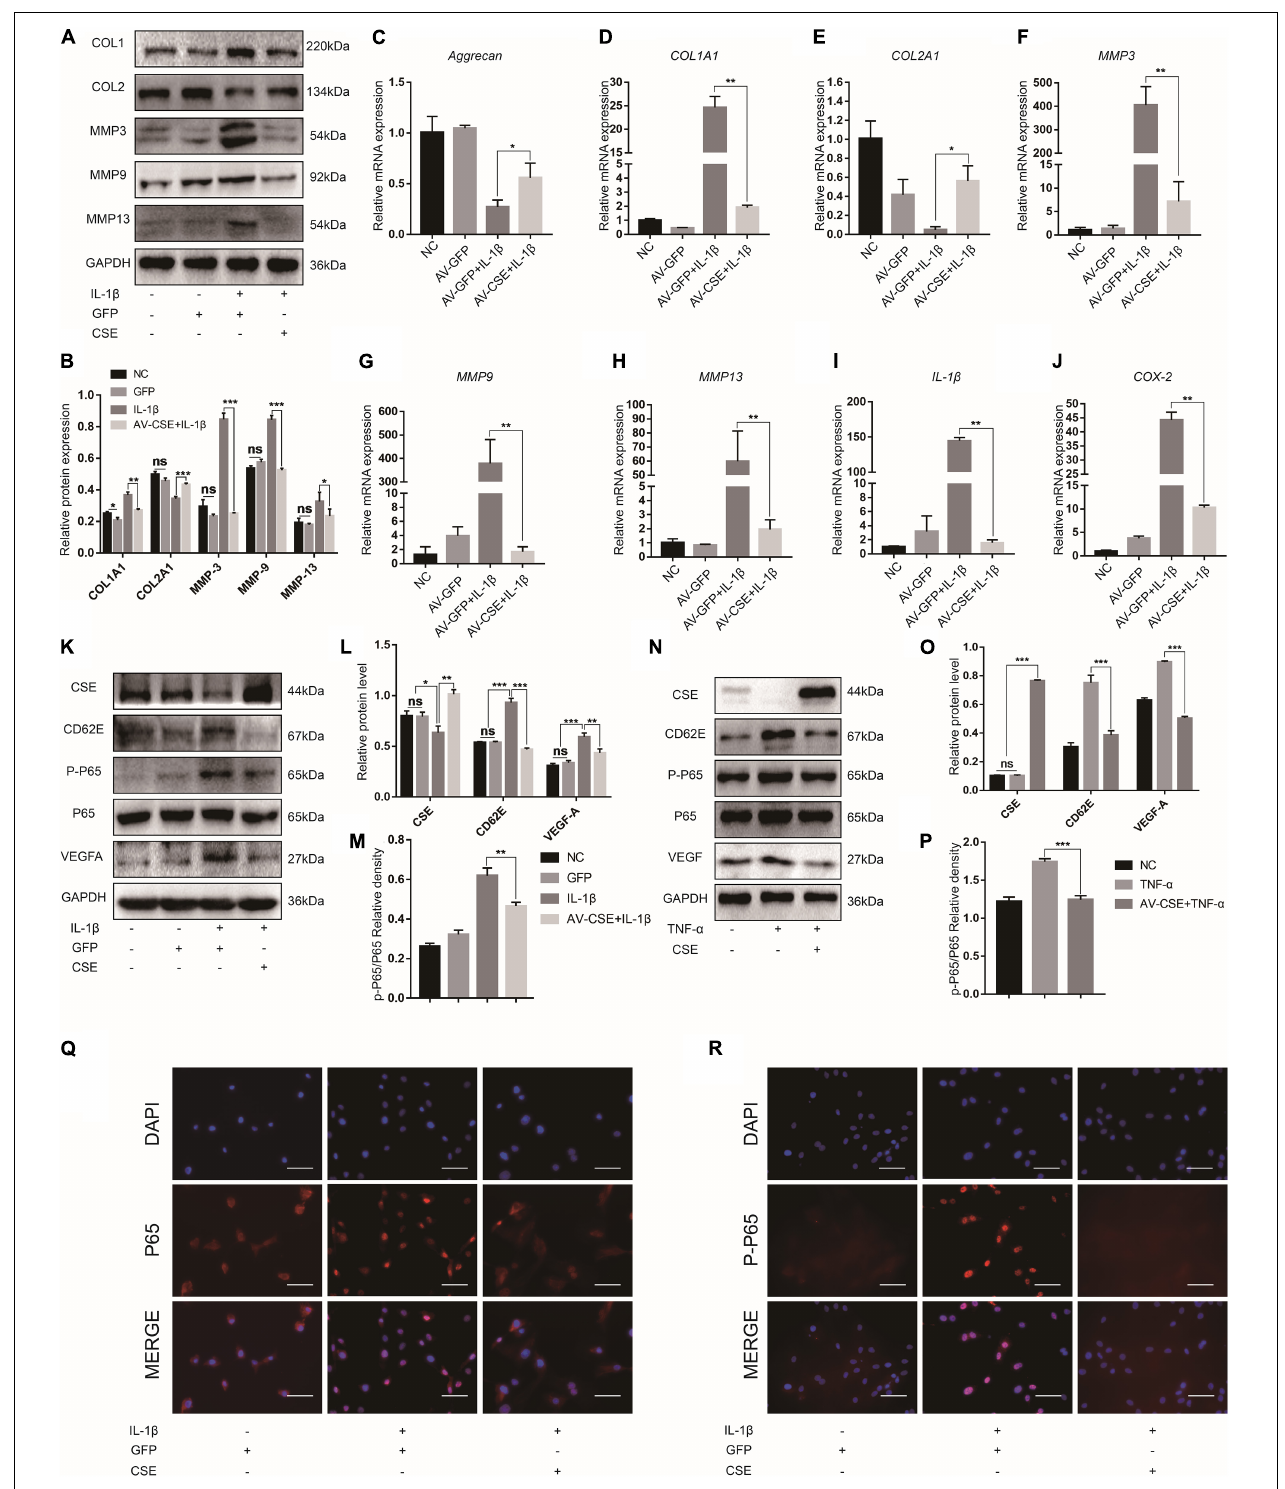
FIGURE 5 | Cystathionine- γ -lyase overexpression inhibits CD62E and NF- κ B signaling pathways in NP cells. (A) Representative western blot images and (B) quantification of effect of CSE overexpression in NP cells. (C–J) RT-PCR measurement of mRNA levels of ECM-encoding genes, ECM-degrading genes, and secreted inflammatory factors. (K) Representative western blot images of CSE, CD62E, P65, p-P65, and VEGF-A and (L,M) quantification (IL-1 β ). (N) Representative western blot images of CSE, CD62E, P65, p-P65, and VEGF-A and (O,P) quantification (TNF- α ). (Q) IF analysis of P65 and (R) p-P65 after IL-1 β treatment. White scale bar: 50 µ